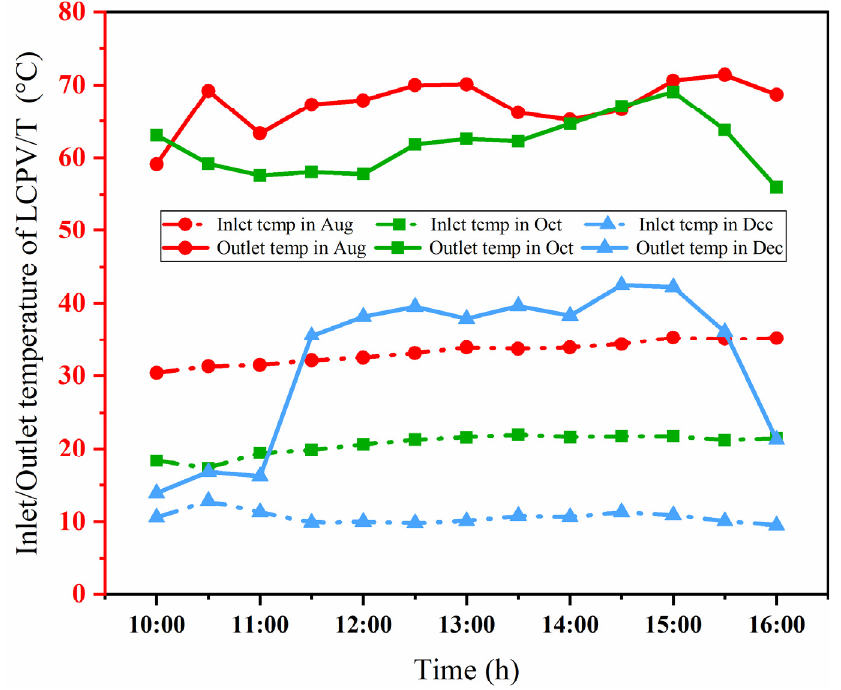
Figure 8. Schematic diagram of seasonal outlet heating